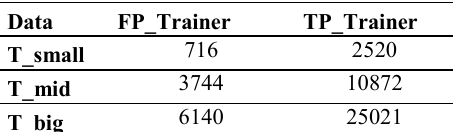
Table 3. Memory Usage on FP_Tainer